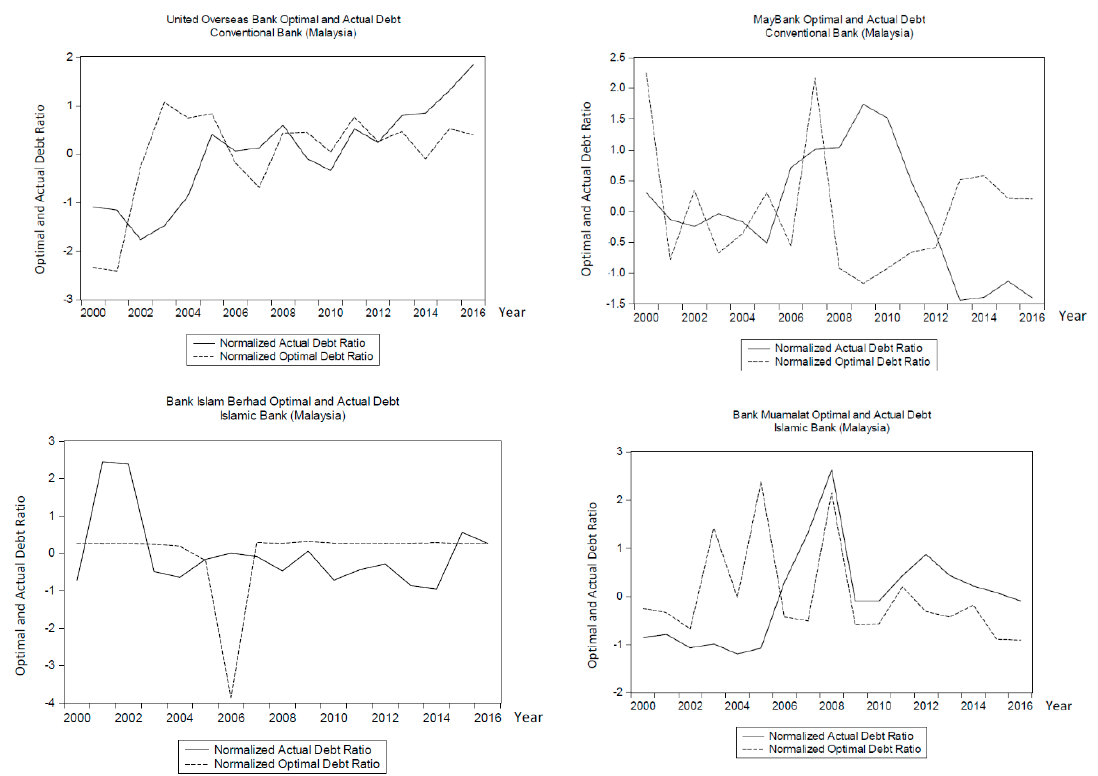
Figure 3. Malaysia optimal- versus actual-debt ratio. Source: Author’s calculations.